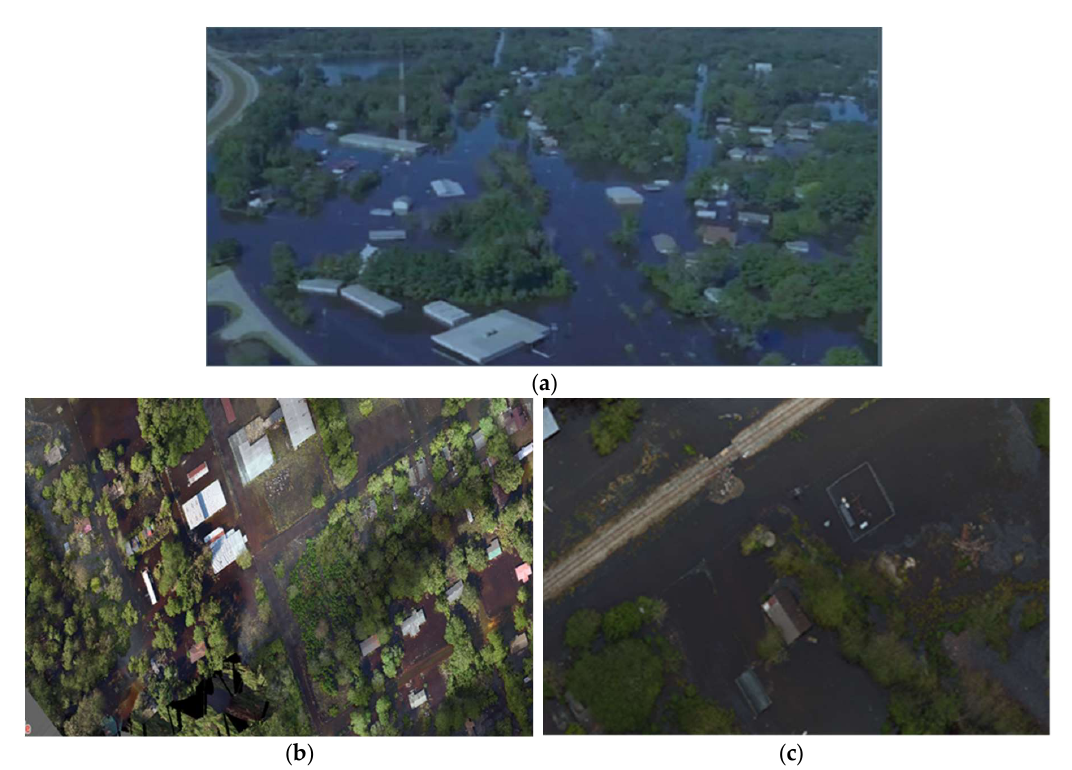
Figure 4. The study areas: ( a ) Princeville ( b ) Lumberton and ( c ) Fair Bluff City.